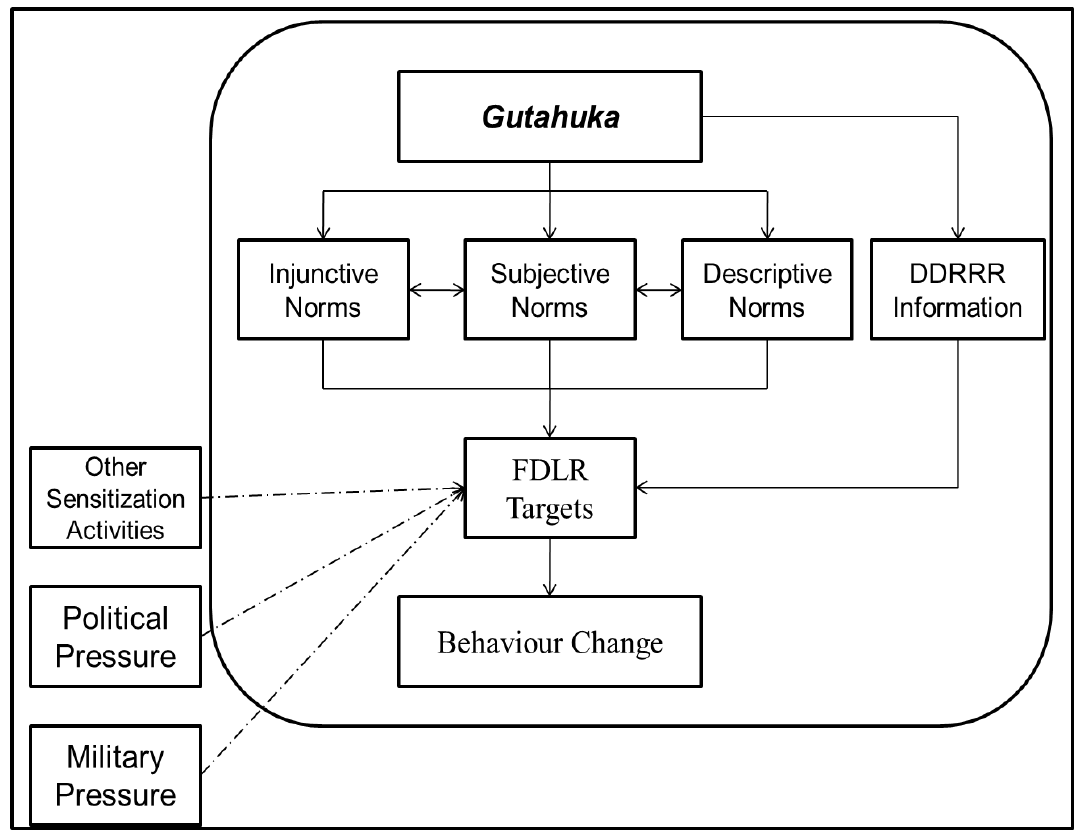
Figure 2. Appeal to norms: The Gutahuka communication